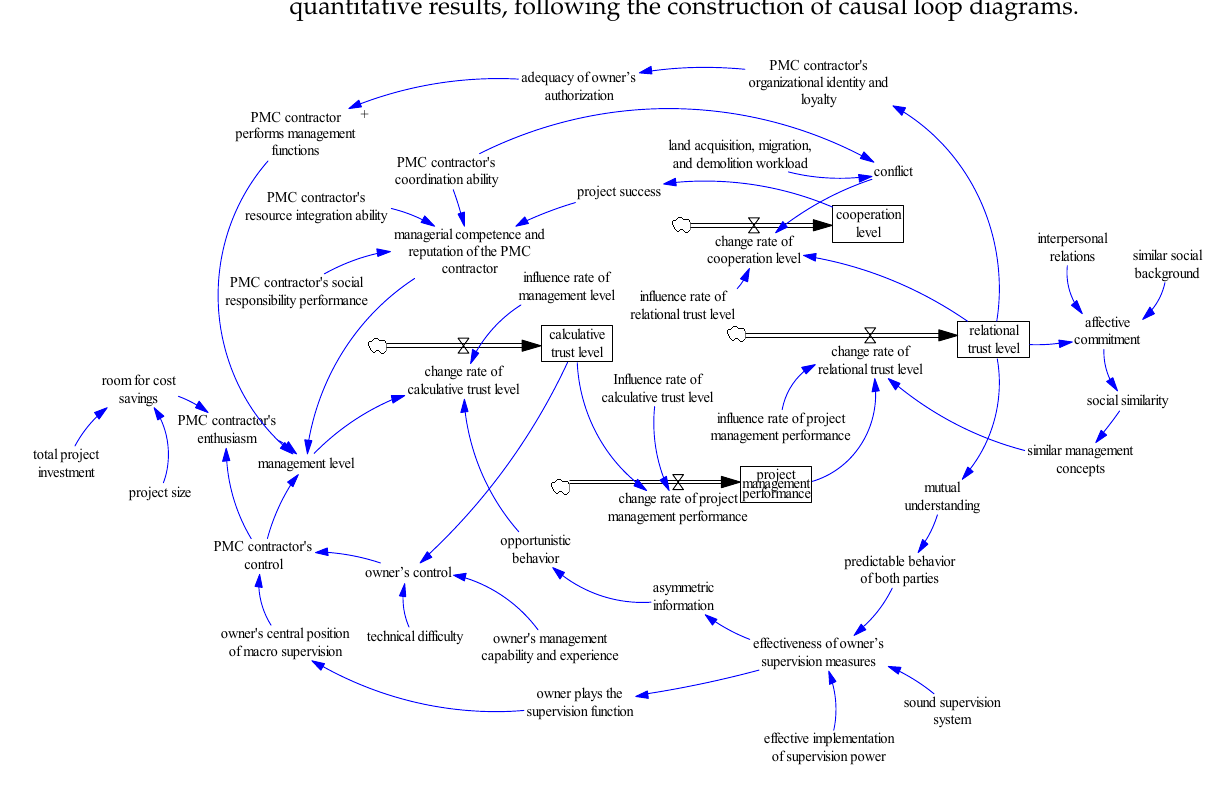
Figure 3. The stock flow diagram.